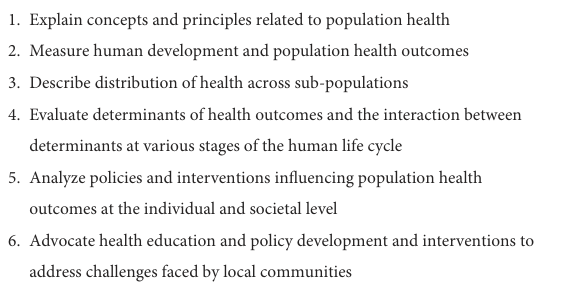
TABLE 1 Population health course learning